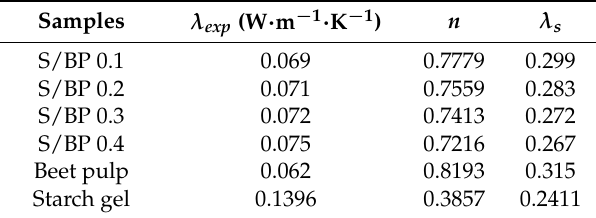
Table 3. Thermal conductivities of apparent agro-materials λ exp and solid particles λ s at 23 ◦ C according to the self-consistent scheme.